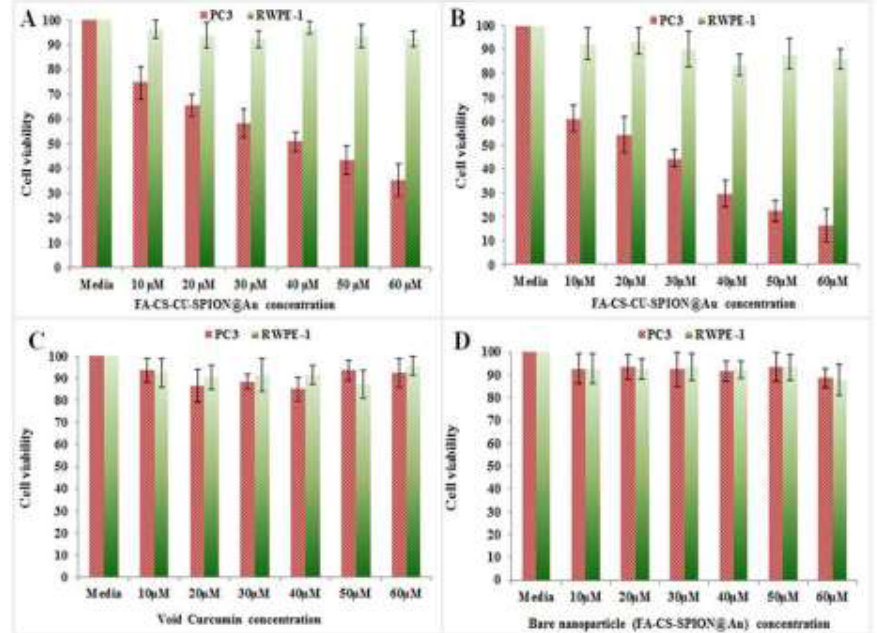
Figure 5. Cytotoxic effect of (10-60 μM) concentrations of FA-CU-CS-Fe@Au NPs after 24 h (A), 48 h (B), and void CU (C) & FA-CS-Fe@Au NPs (D) at 48 h on PC3 and RWPE-1 cell lines. The FA-CU-CS-Fe@Au NPs IC50 value for PC3 cell lines was 54 μM within 24 h which was reduced relative